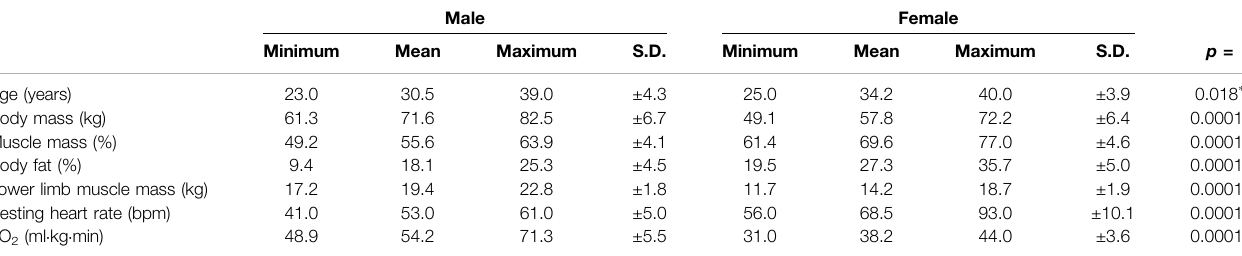
TABLE 1 | Characterization of the female and male groups. The absolute values and means of each characteristic are shown.